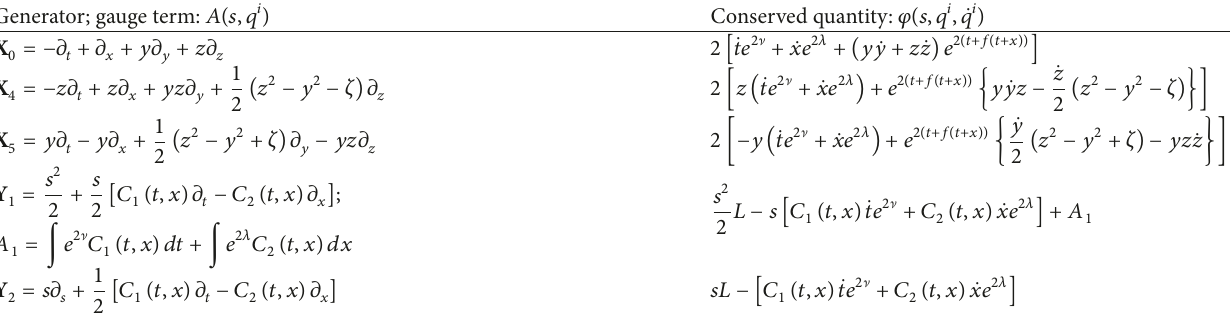
Table 18: Conserved quantities corresponding to each Noether symmetry.